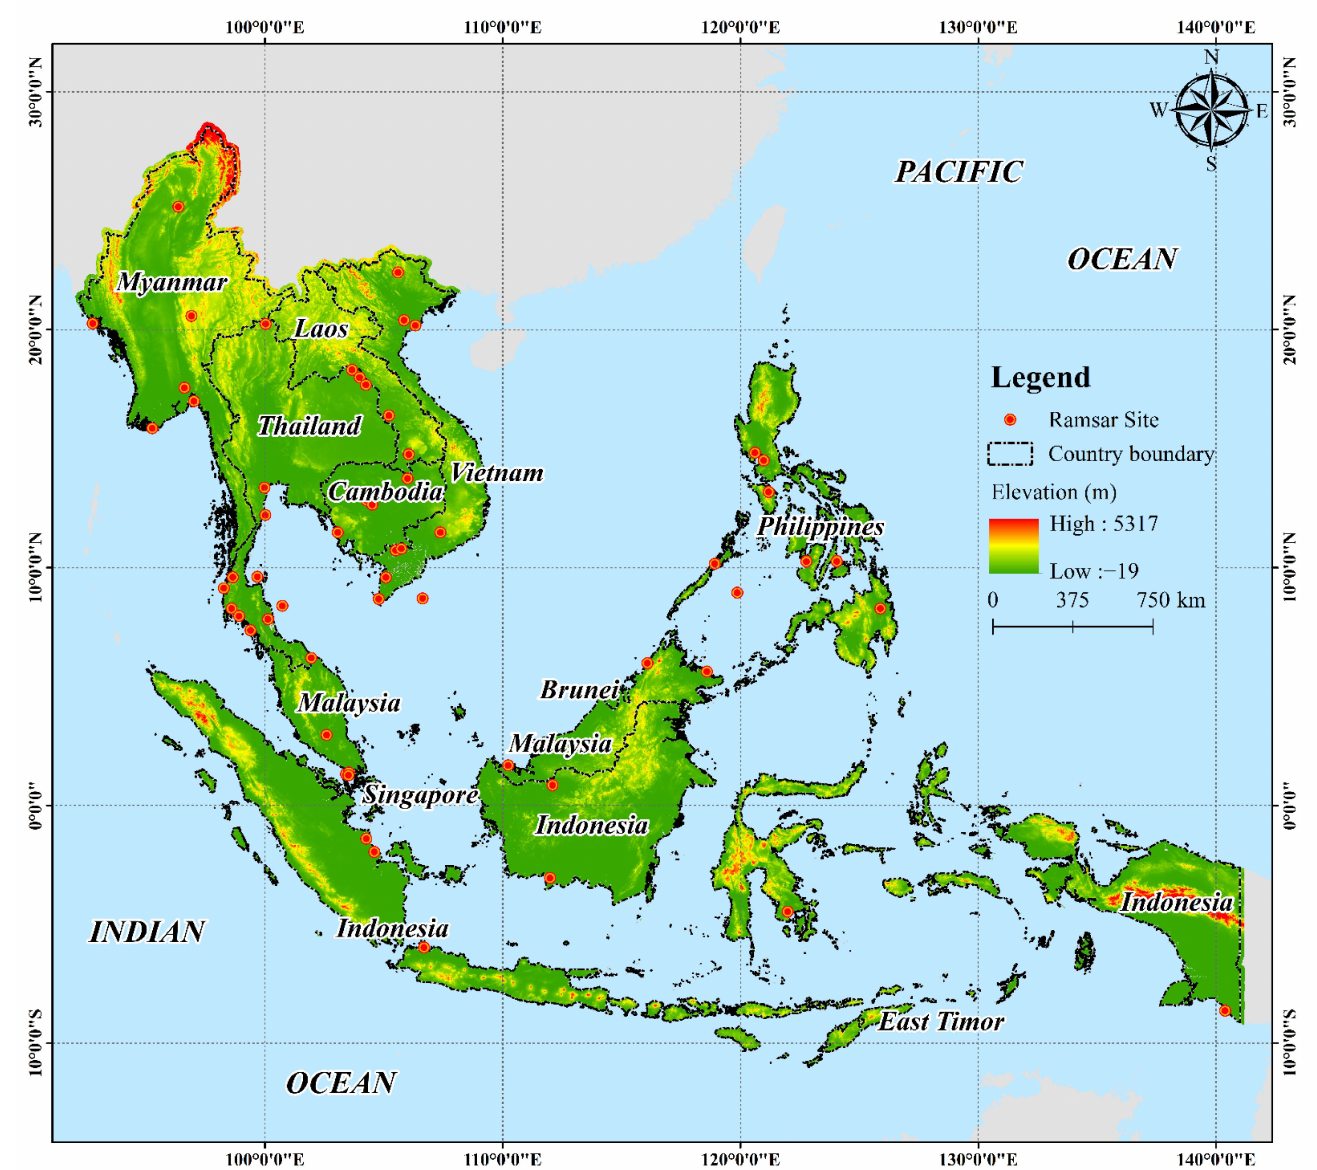
Figure 1. A map of the study